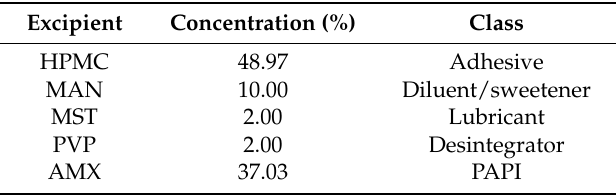
Table 2. Final formulation of the mucoadhesive